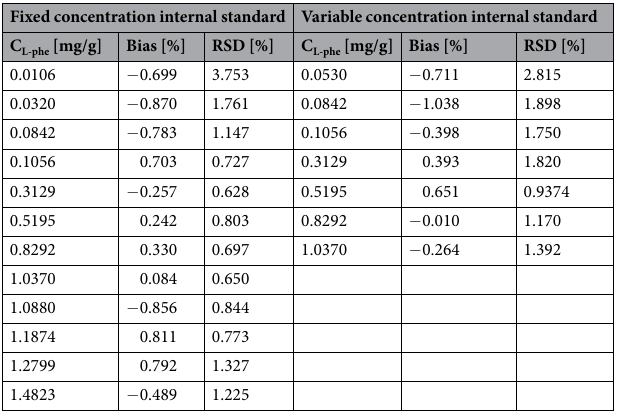
Table 3. Method performance of L-phenylalanine quantitation by HPLC-CD.